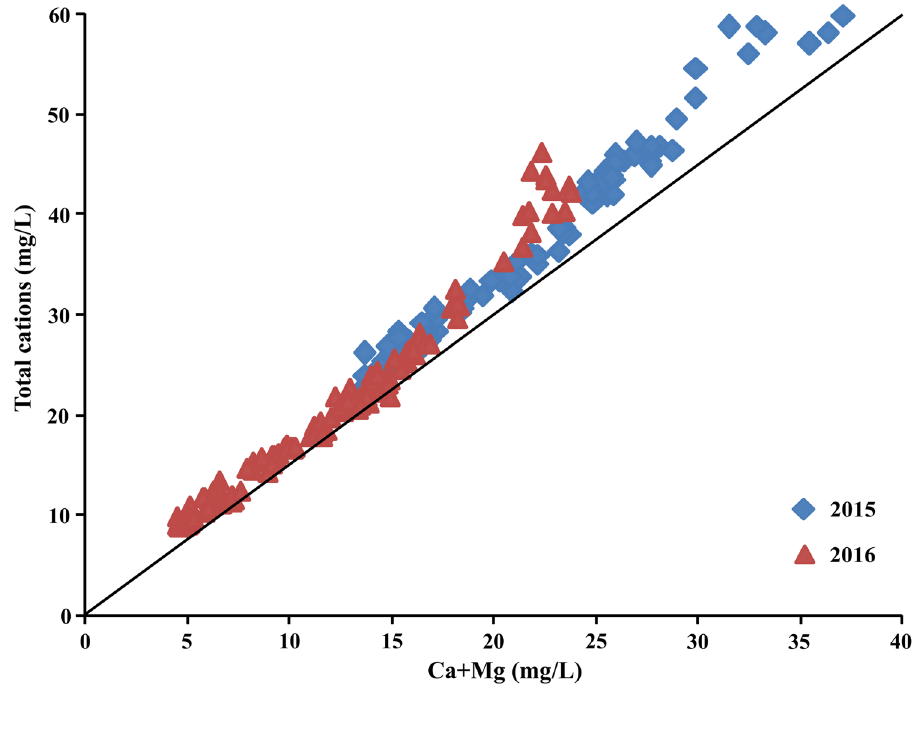
Fig. 6 Scatter plot between total cations and (Na + K) for glacier